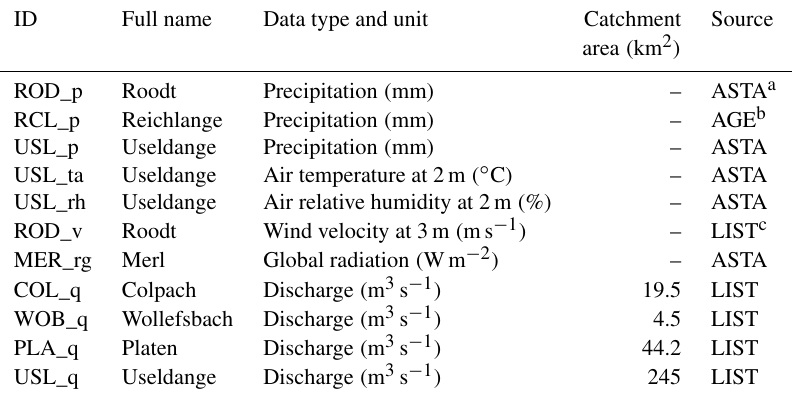
Table A2. Time series data used for model calibration, validation, and operation. All data were available in 1h resolution for the period of